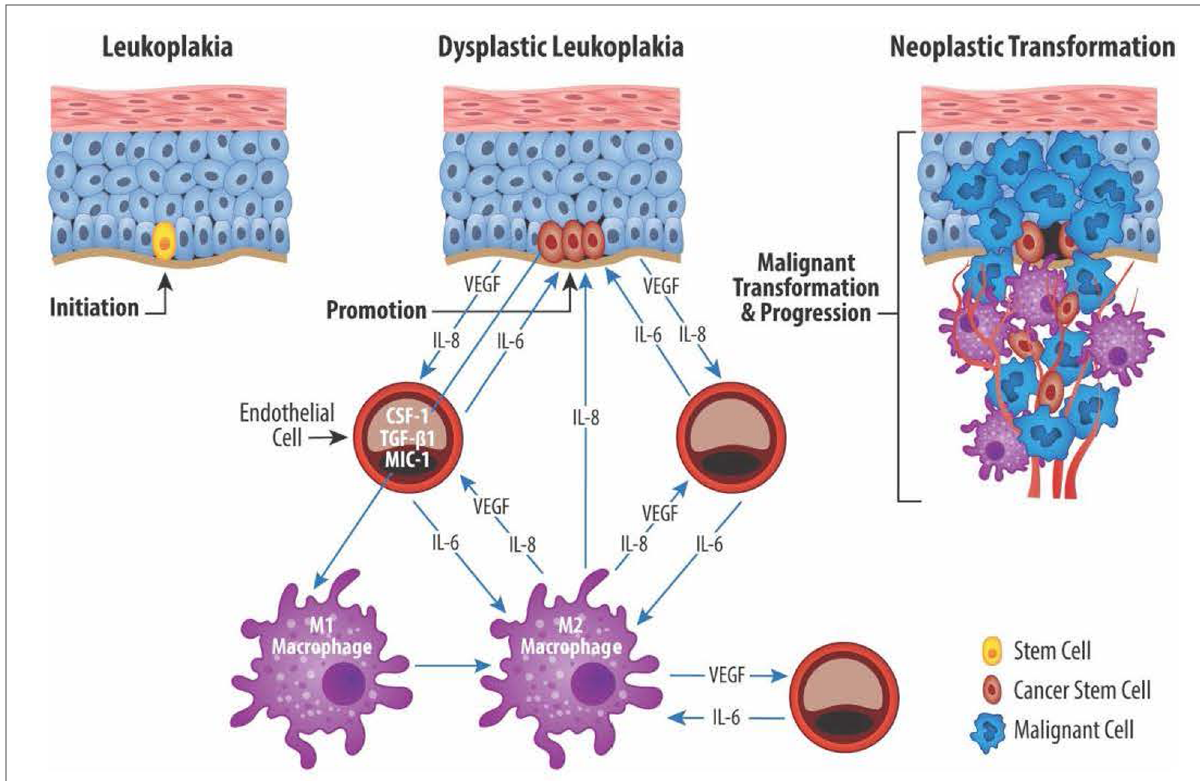
FIGURE 2 Reciprocal exchange of cytokine mediators between cancer stem cells (CSC), endothelial cells (EC), and macrophages (M1 and M2). CSC located in the basal layer of dysplastic epithelium produce, among others, the angiogenic mediators VEGF and IL-8. EC in turn produce IL-6 which plays